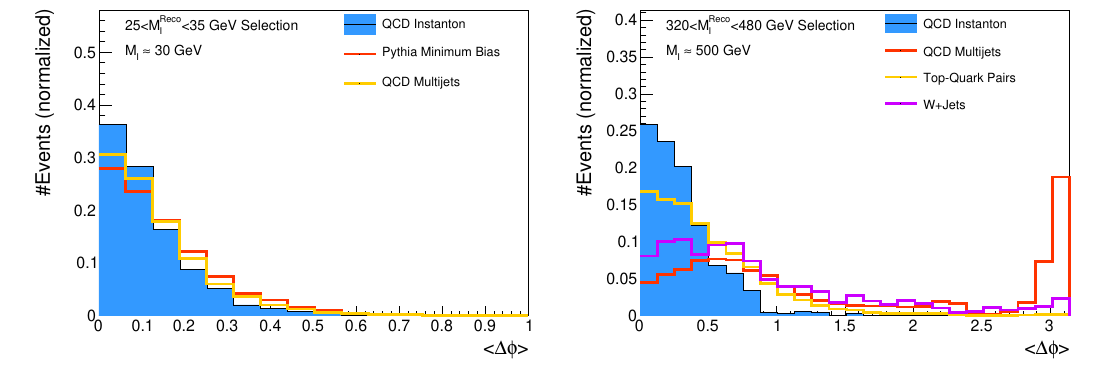
Figure 10 . Normalized distributions for average angles between reconstructed tracks for events with 25 < M reco < 35 GeV (left) and between reconstructed particle-jets for events with I 320 < M reco < 480 GeV (right). Beside the signal processes, the expected distributions of the back- I ground processes are shown (see table